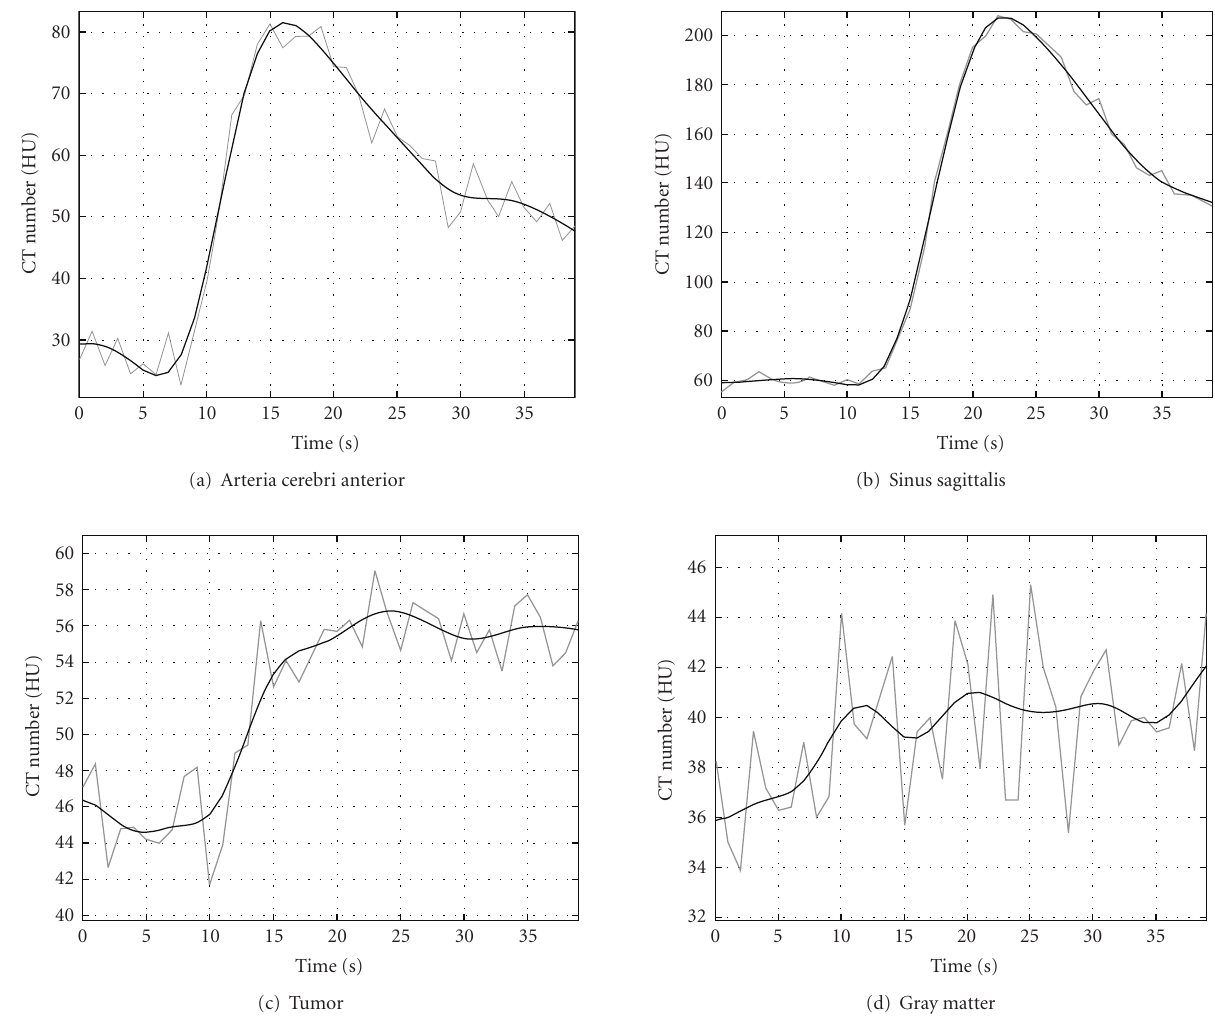
Figure 9: Example of TACs in di ff erent tissues. The gray curve corresponds to the original dataset. The black curve corresponds to the low-noise sequence.